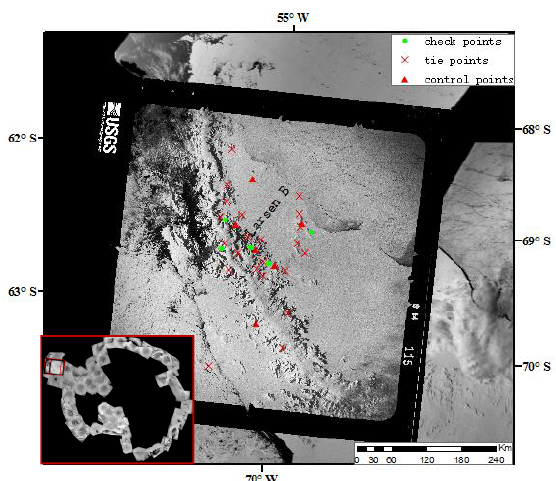
Figure 2. The location of Larsen B with an ARGON mosaic as background (Kim et al. 2007). And the distribution of tie points, ground control points and check points